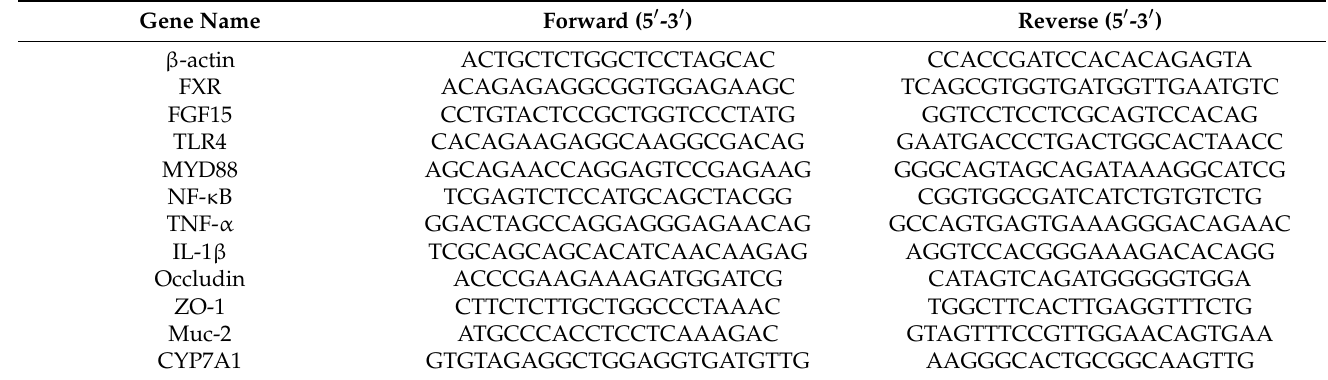
Table 2. RT-PCR amplified primers.